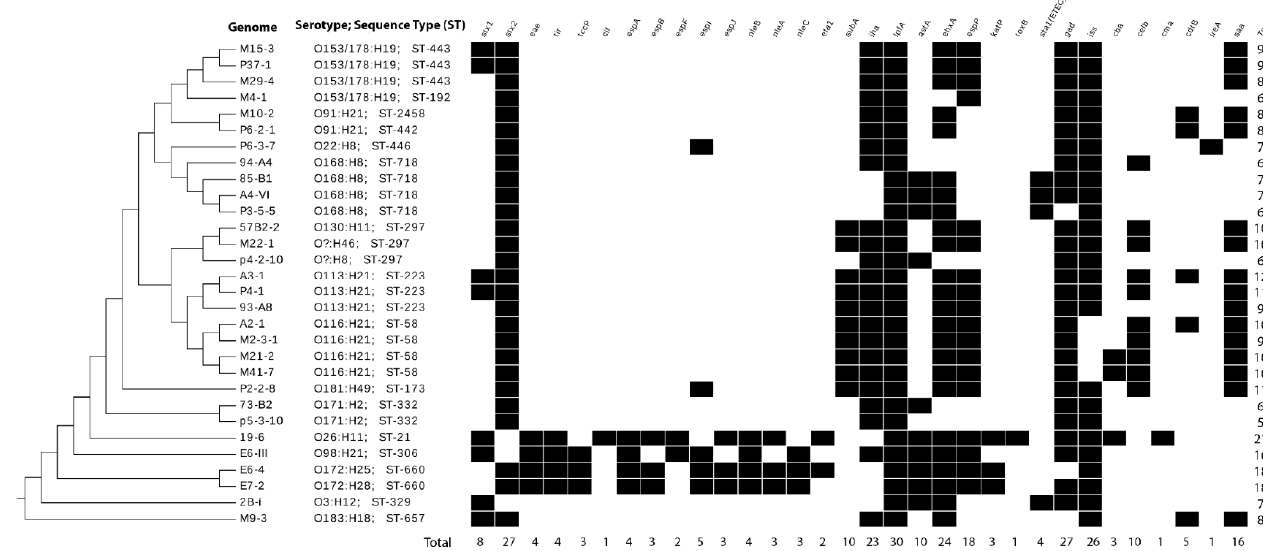
Figure 3. Matrix of the presence/absence of virulence genes in STEC genomes isolated from cattle in Chile ( n = 30). Black filling indicates that the gene is present. All genes but saa were surveyed in each genome using the VirulenceFinder software from DTU [36]. Gene saa was screened through PCR and confirmed by in silico PCR from their WGS and primers described in Lucchesi et al., 2006 [31].